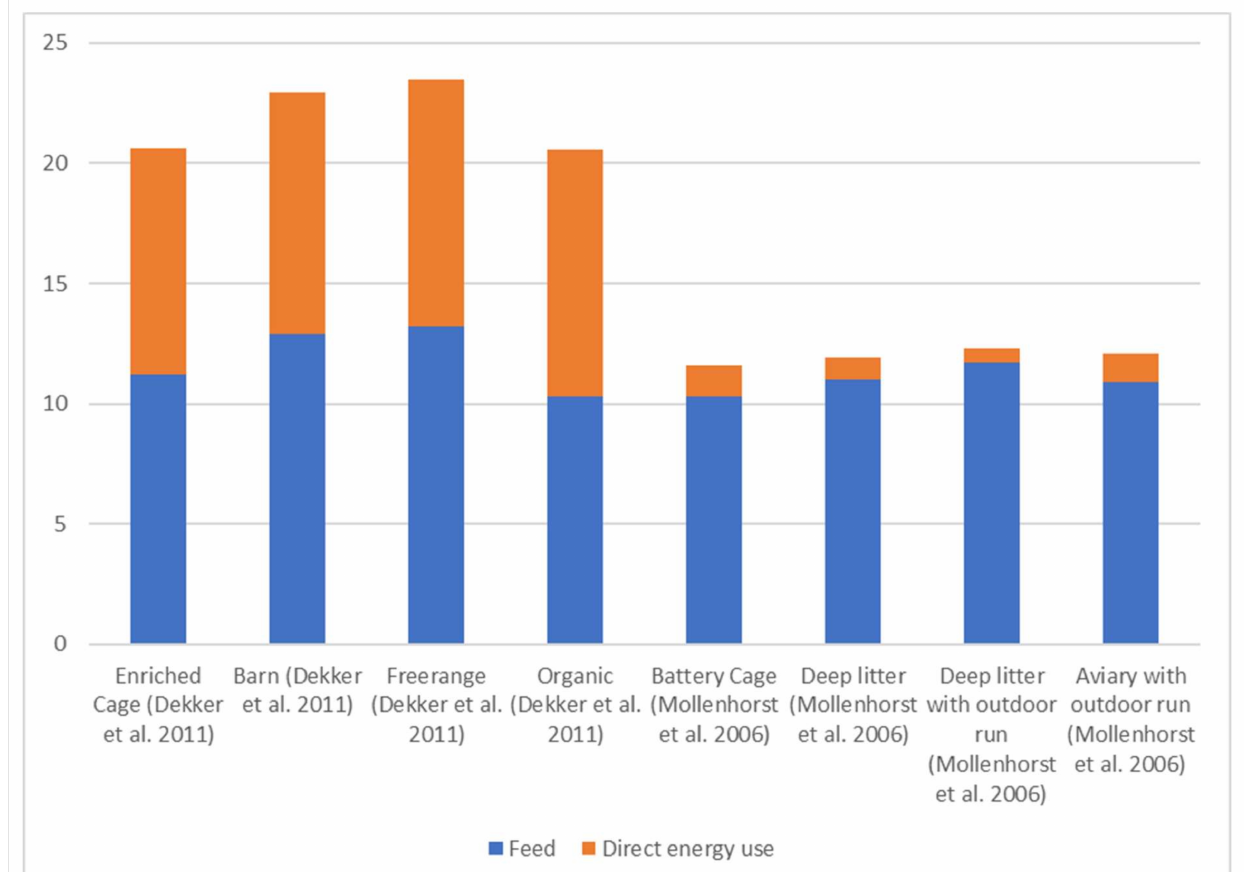
Figure 7. Energy inputs for egg-producing systems MJ/kg (based on